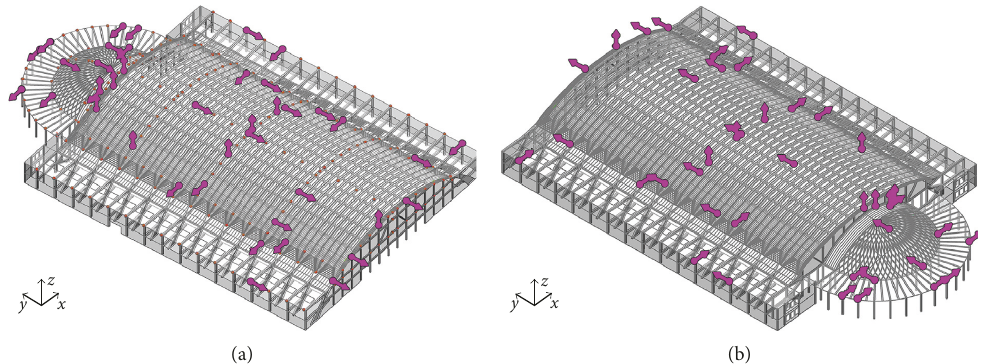
Figure 19: Sensor configuration layout: placement of sensors for the undamaged structure, after the weighting of the different contributions. Also in the damaged configuration, there was an improvement in the placement of sensors. The sensors are oriented especially in the y direction Figure 20.